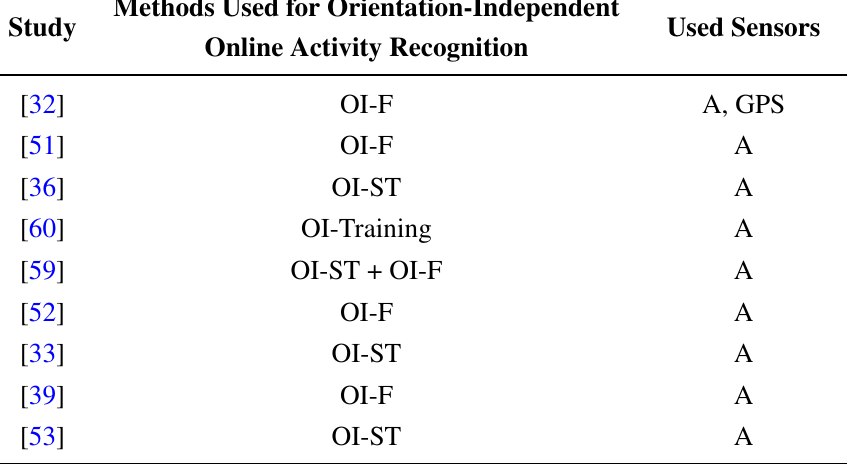
11. Studies with orientation-independent activity recognition. OI-F, orientation-independent features; OI-ST orientation-independent signal transformation. Methods Used for Orientation-Independent Study Used Sensors Online Activity Recognition [32] OI-F